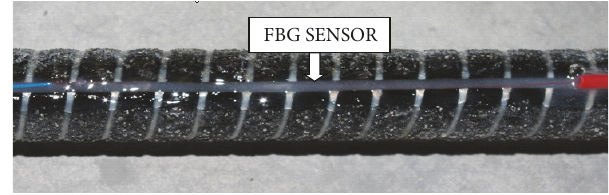
Figure 5: FBG sensor location on BGFRP